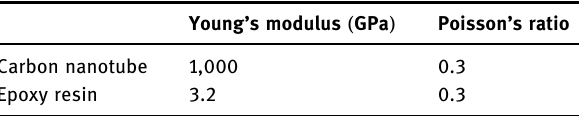
Table 1: Material data